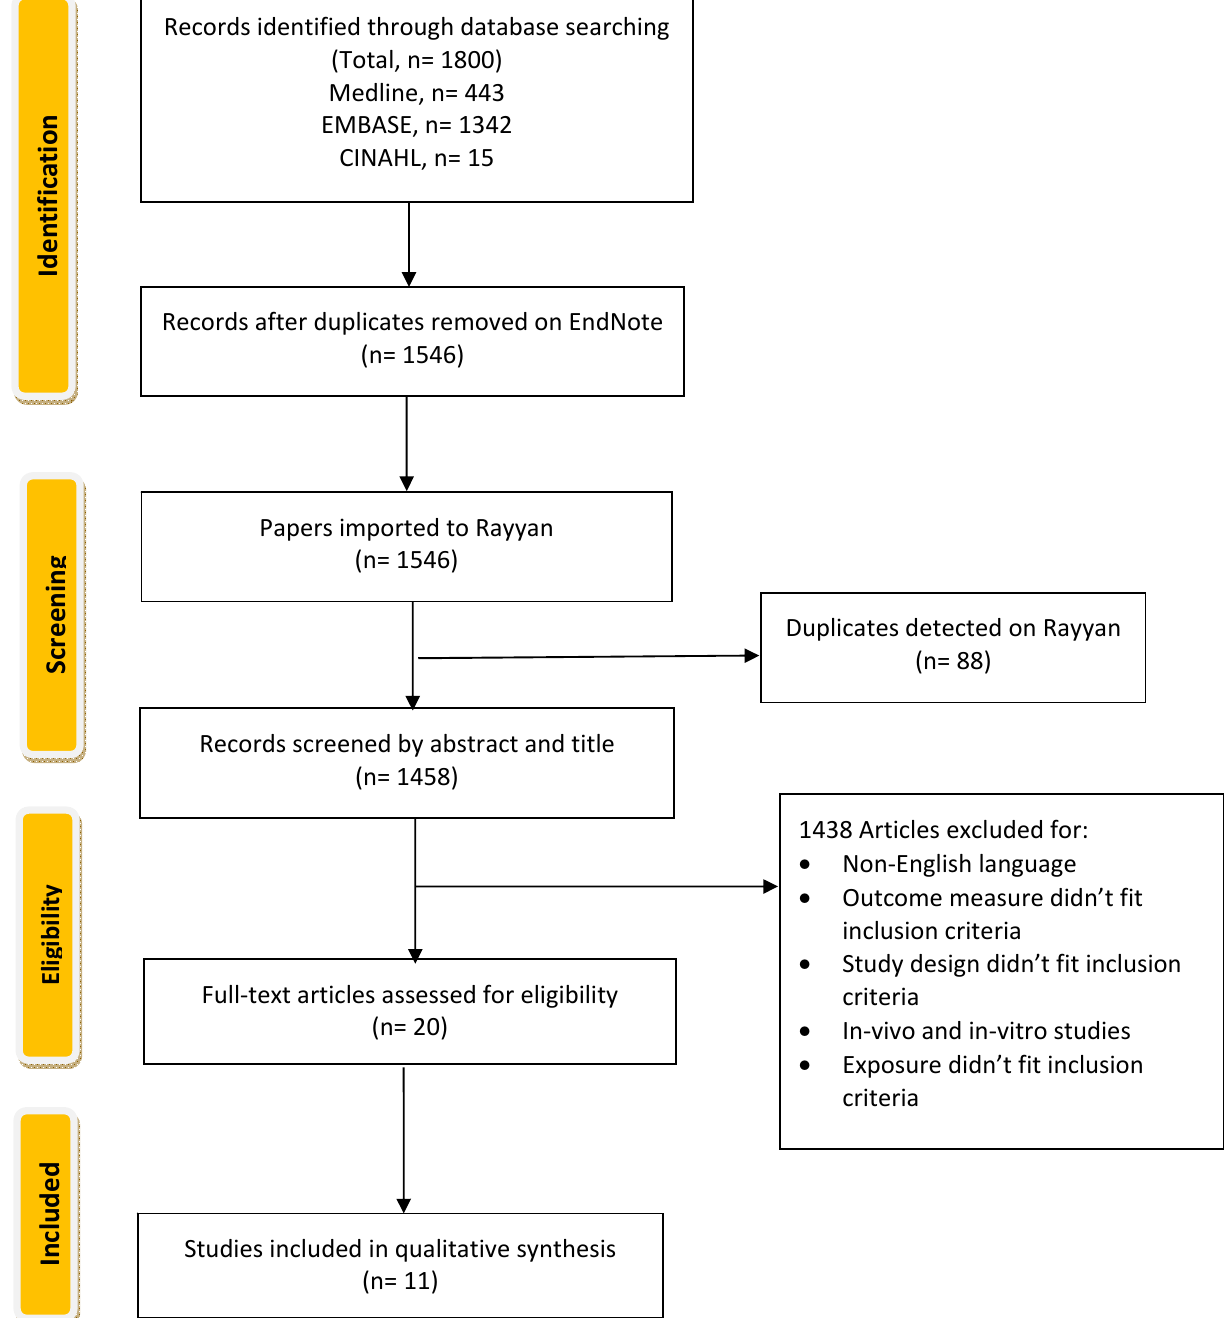
Figure 1. Flow chart of The Systematic Review of Copper Intake and Type 2 Figure 1 . Flow chart of The Systematic Review of Copper Intake and Type 2 diabetes